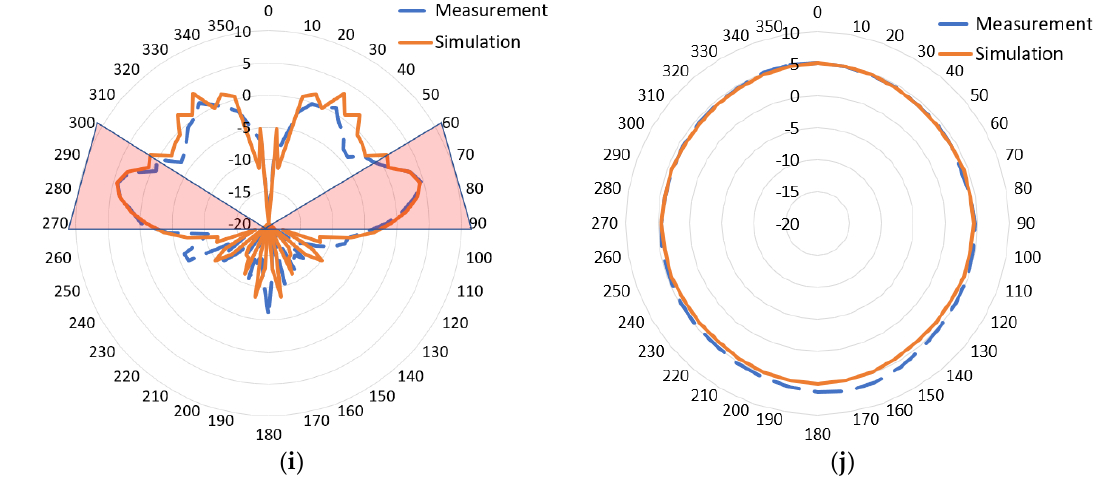
Figure 15. 2D Radiation pattern for ( a ) 0.84 GHz elevation plane ( φ = 90); ( b ) 0.84 GHz azimuth plane ( Θ = 75); ( c ) 1.9 GHz elevation plane ( φ = 90); ( d ) 1.9 GHz azimuth plane ( Θ = 75); ( e ) 2.6 GHz elevation plane ( φ = 90); ( f ) 2.6 GHz azimuth plane ( Θ = 75); ( g ) 3.9 GHz elevation plane ( φ = 90); ( h ) 3.9 GHz azimuth plane ( Θ = 75); ( i ) 4.7 GHz elevation plane ( φ = 90); ( j ) 4.7 GHz azimuth plane ( Θ = 75). The elevation plane radiation pattern at φ = 90 ◦ for the frequencies 0.84